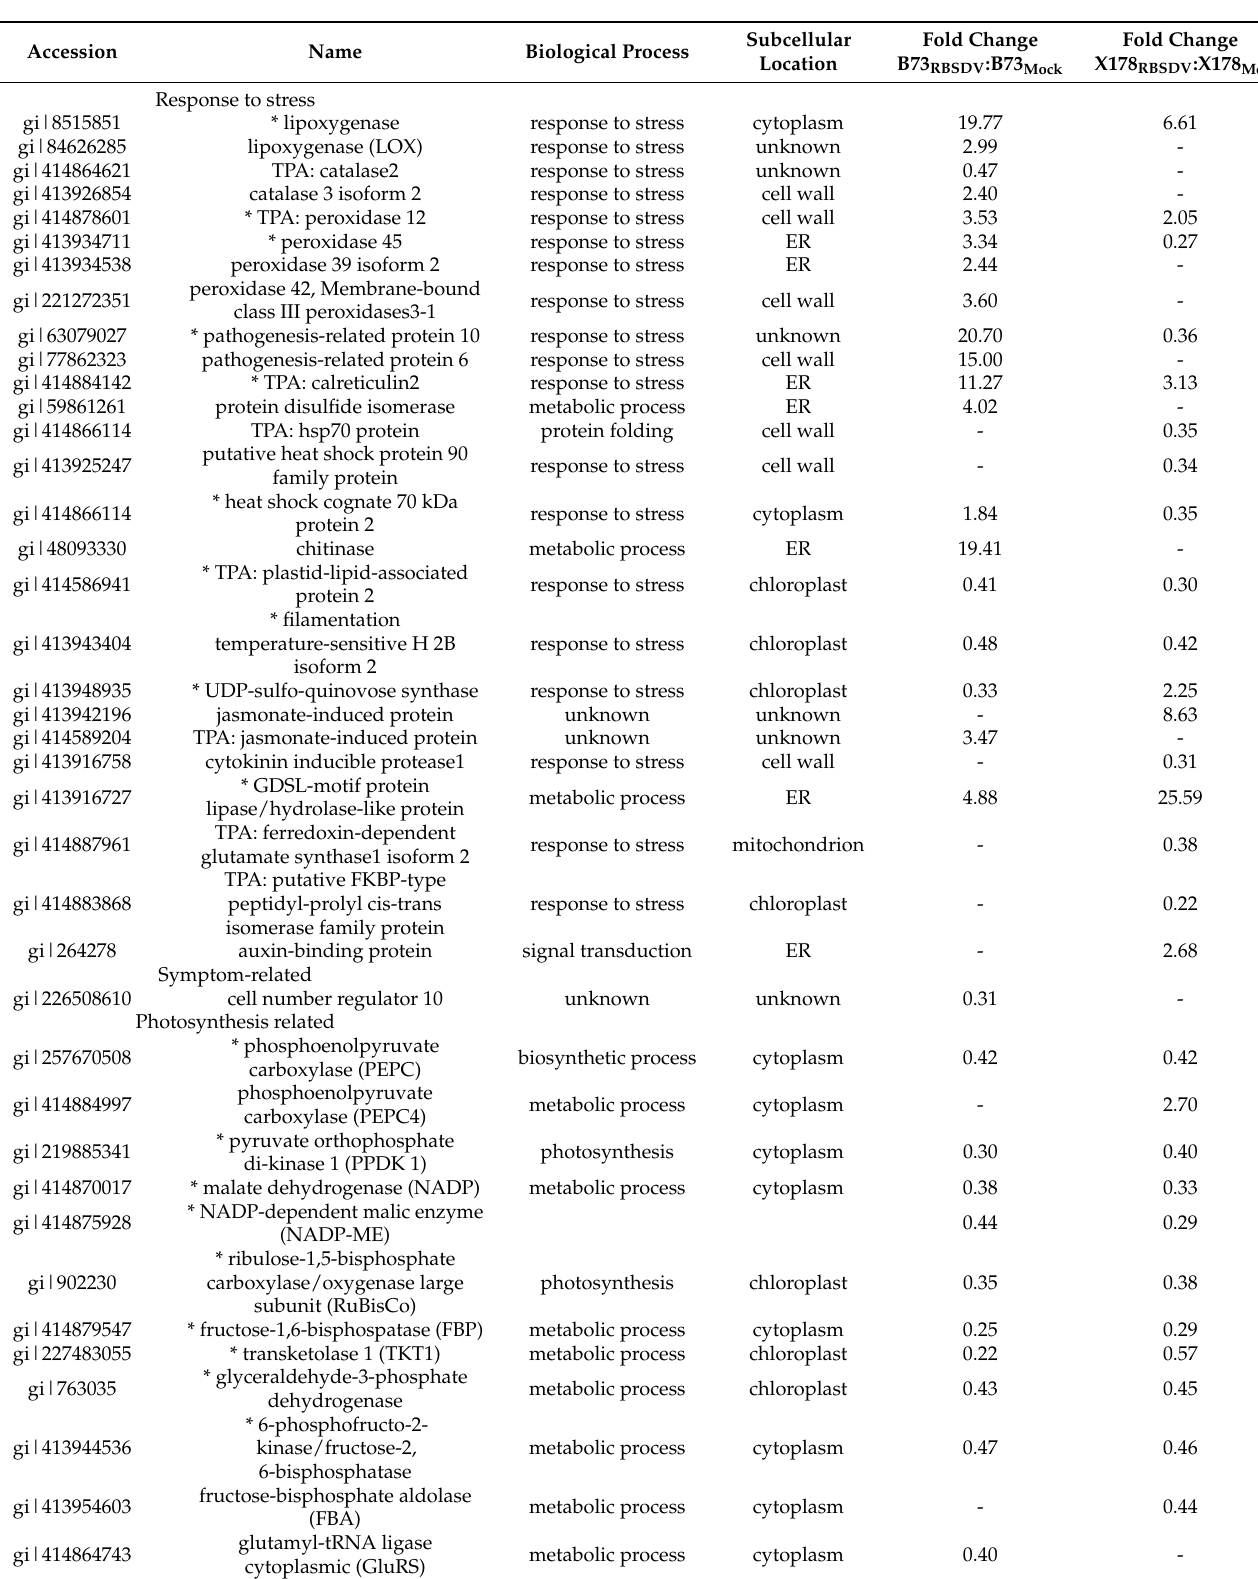
Table 1. List of rice black-streaked dwarf virus (RBSDV) infection-regulated proteins in leaves of maize inbred lines B73 and X178 and their